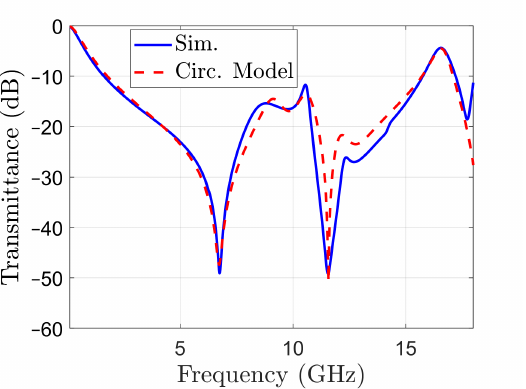
Figure 8. Transmittance of the full structure: calculated with the circuit model of the unit cell (dashed line) and obtained by simulation (solid